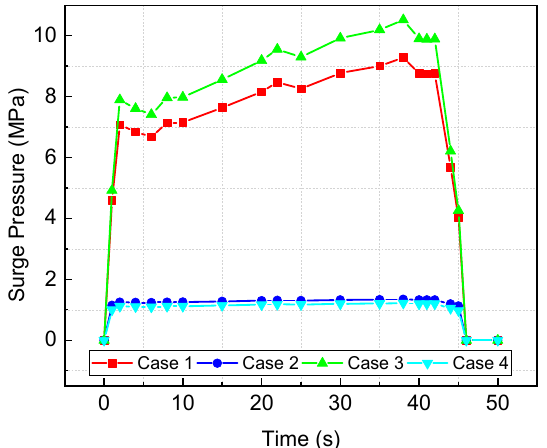
Figure 11. Comparison of predicted and measured values of surge pressure under different conditions.